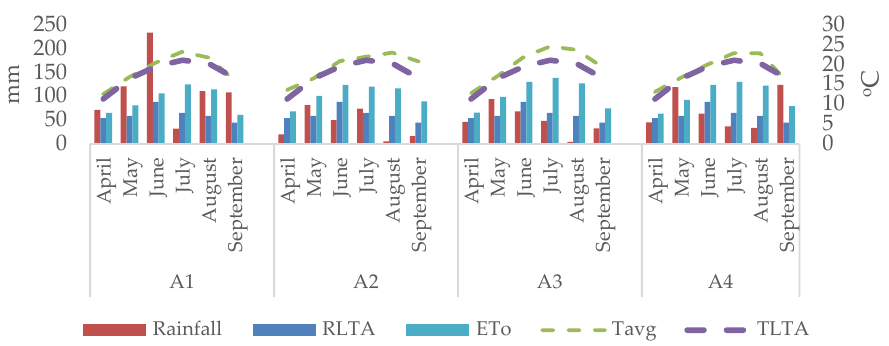
Figure 1. Amount of rainfall (mm), ETo (mm/month) and air temperatures (°C, Tavg) during the four growing seasons (A1–A4), rainfall long-term averages (RLTAs) and temperature long-term averages (TLTAs). Table 1. Physical and chemical properties of the soil at the study site (P = porosity; RC = retention capacity; AC = air capacity; PWP = permanent wilting point (vol.%); PD = particle density; SOM = soil organic matter).